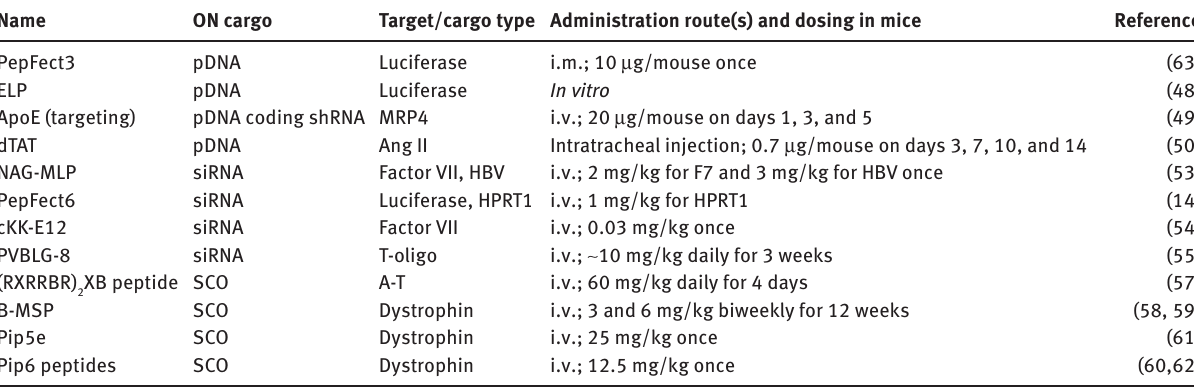
Table 3 Summary of described peptides-based delivery vectors for genetic